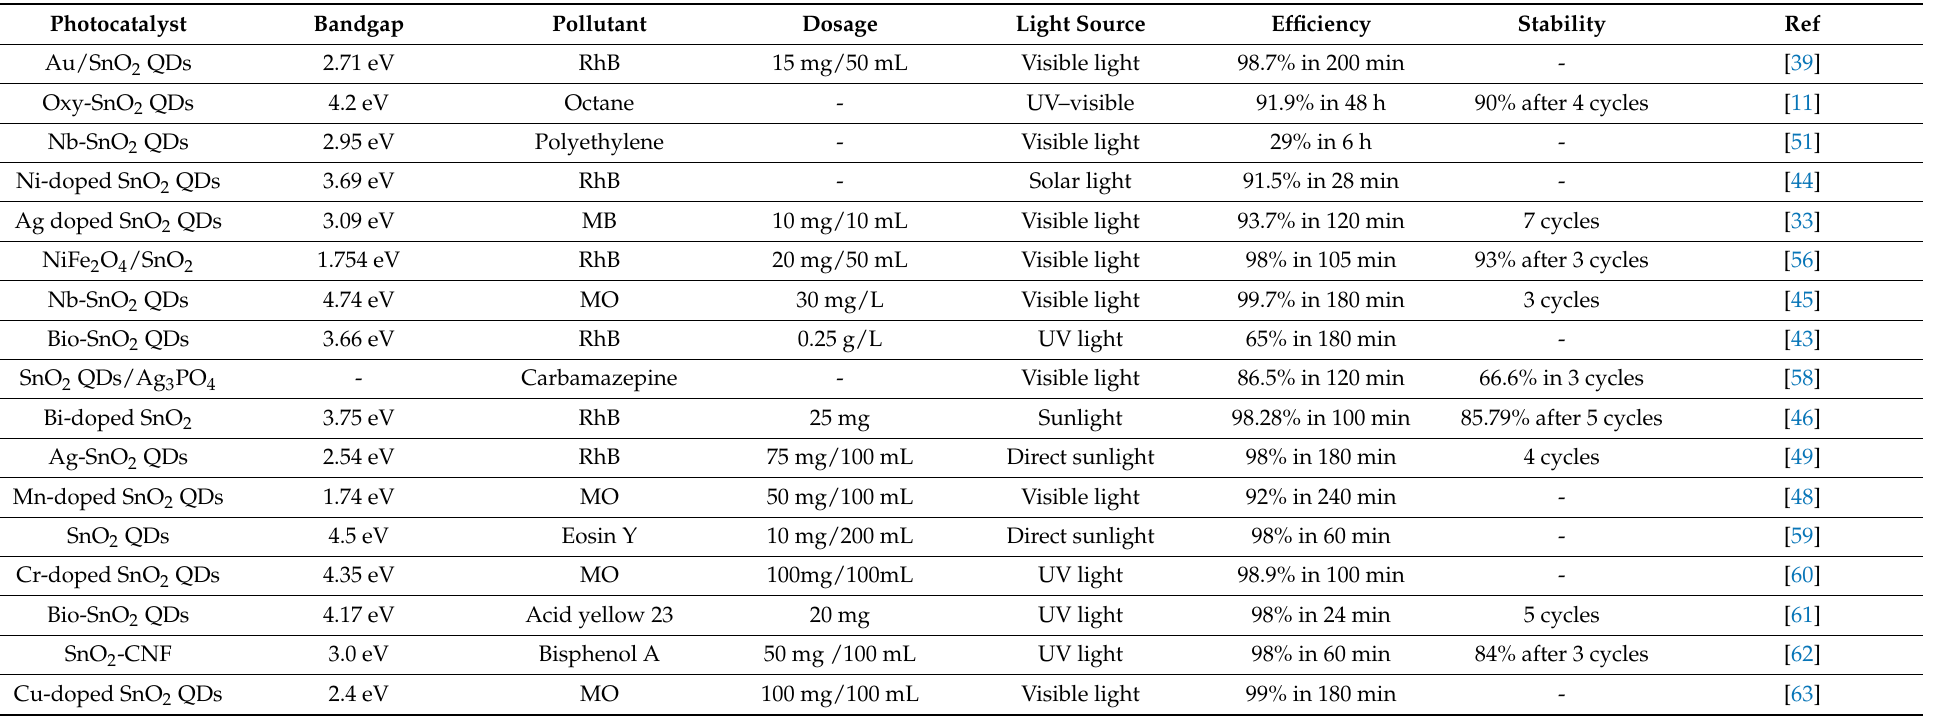
Table 2. Detailed description of recent research on the photocatalytic abilities of SnO 2 QD-based